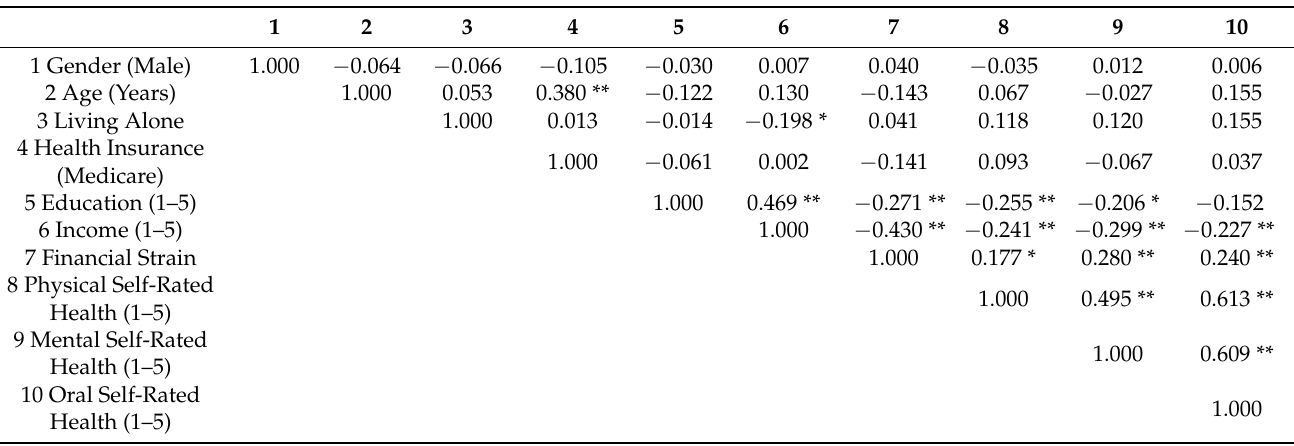
Table 2. Bivariate correlations (Spearman correlation).